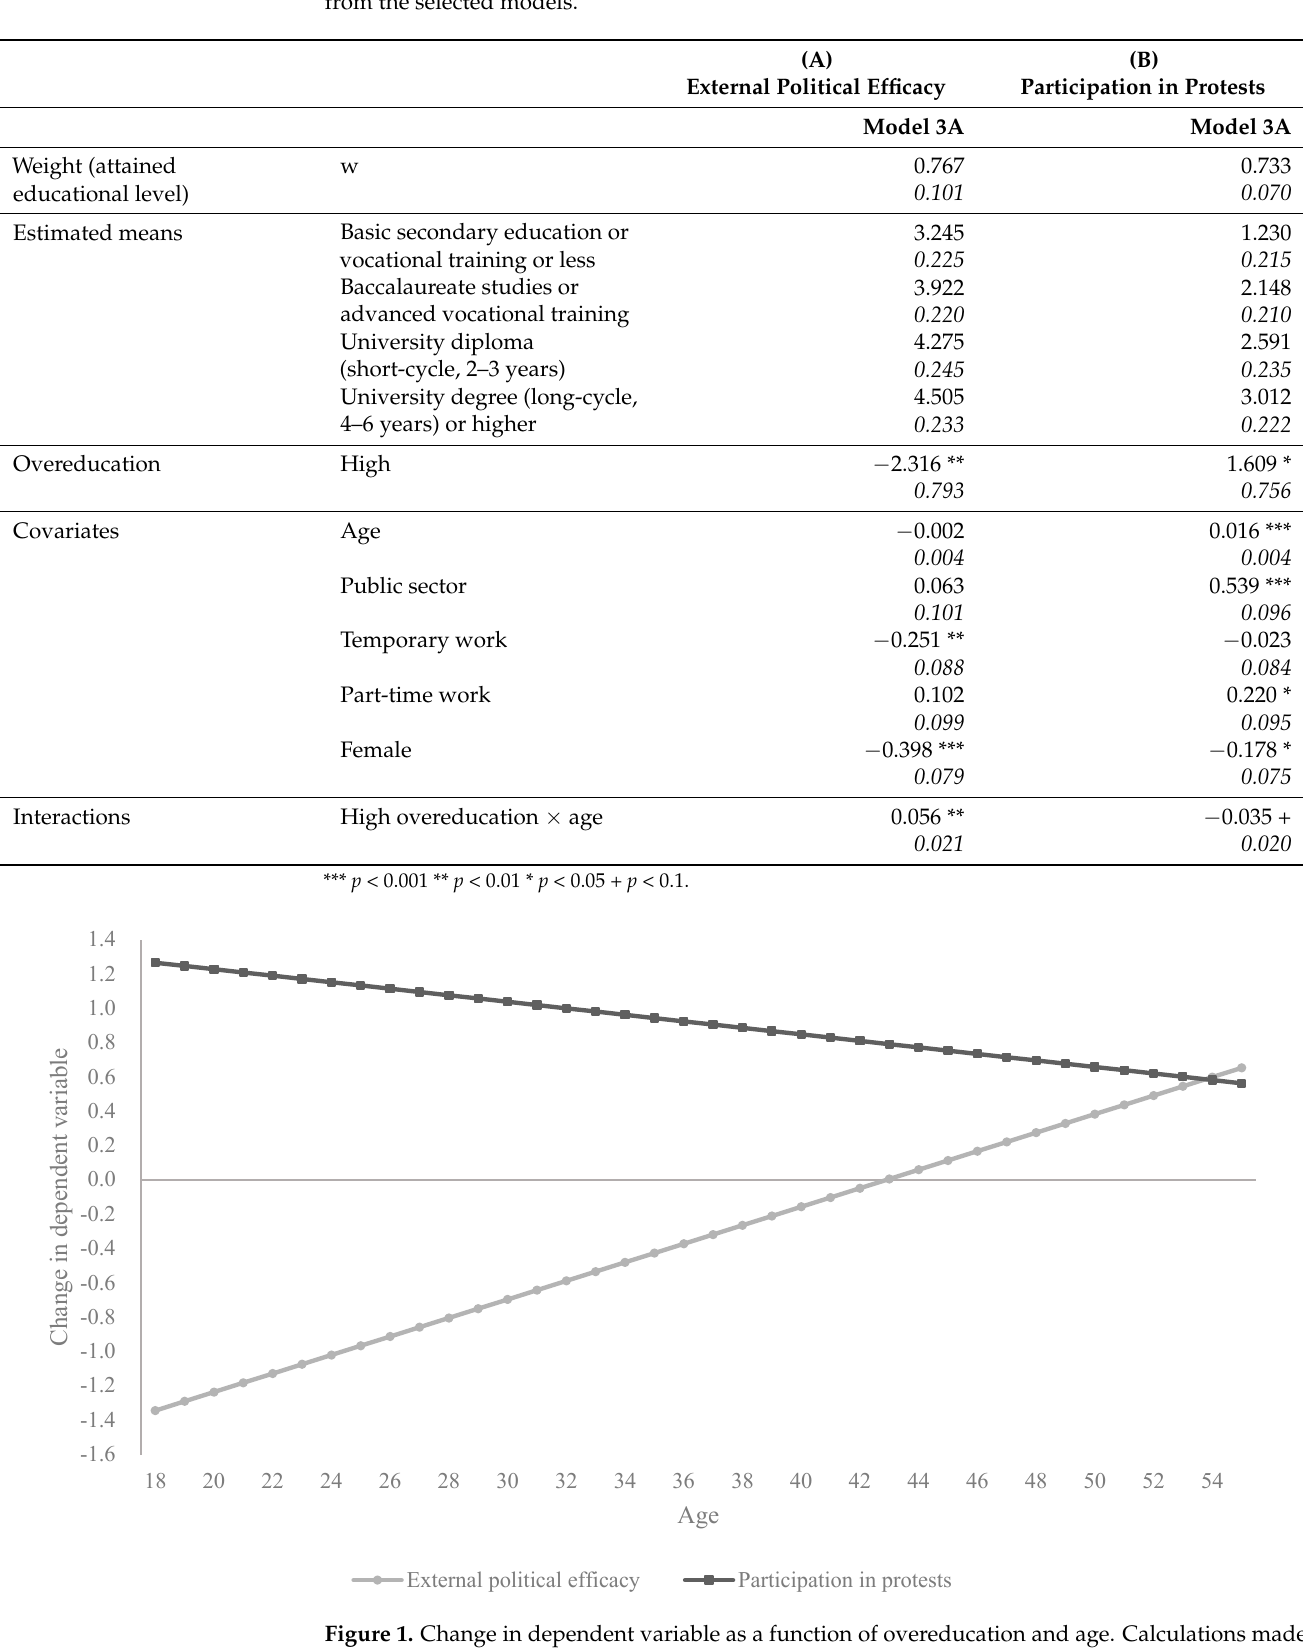
Table 4. Heterogeneous effects models (variations by age). Estimated parameters and standard errors from the selected models.